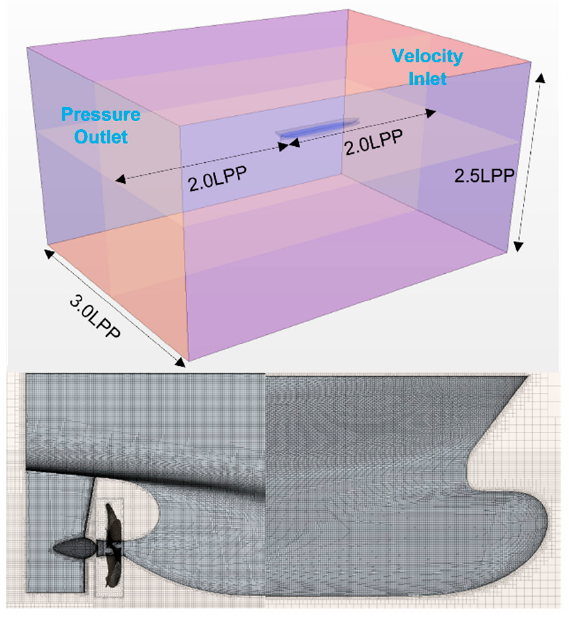
Figure 7. Boundary condition and grid system of the 1800 TEU Container Ship.